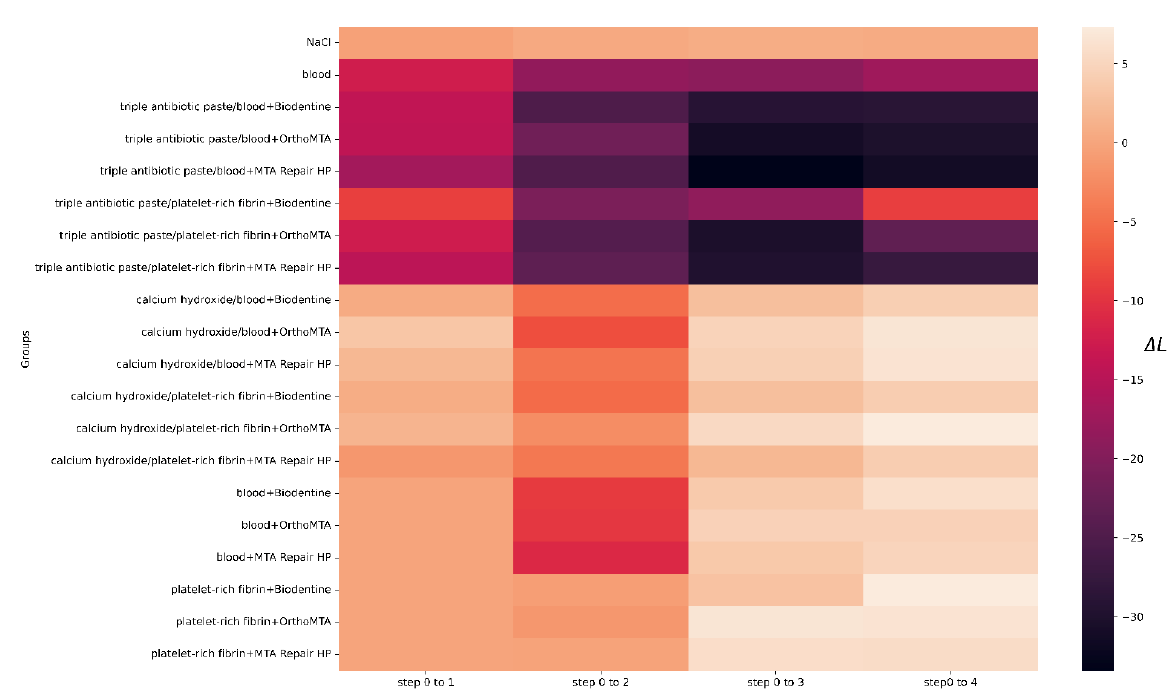
Figure 6. Values of L for all groups and steps.